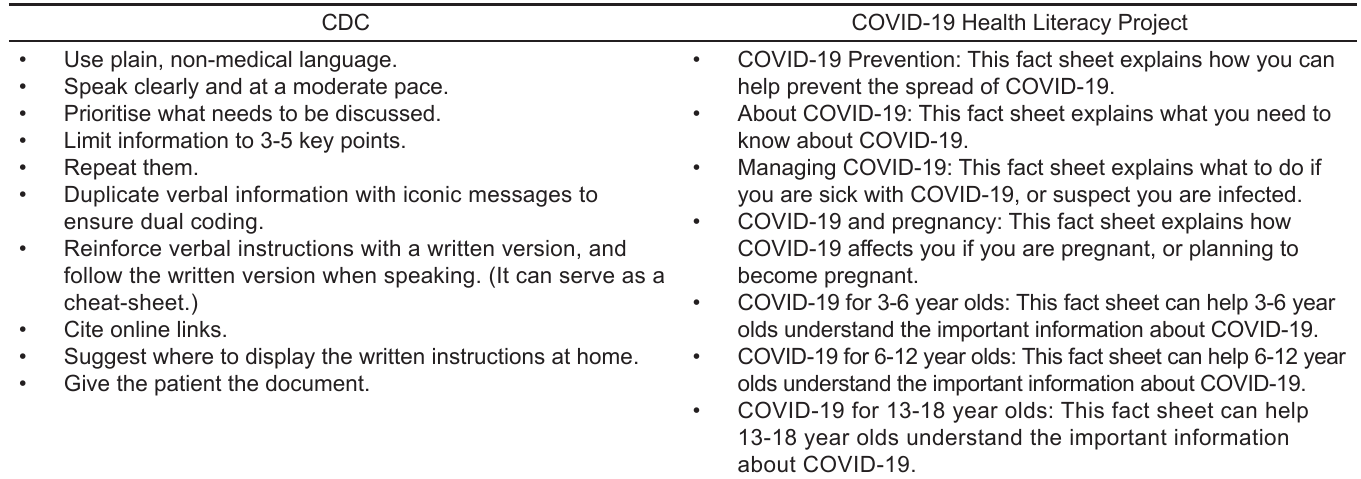
Table 4. Coronavirus 2019 resources for patients (from the CDC* and the COVID-19 Health Literacy Project).